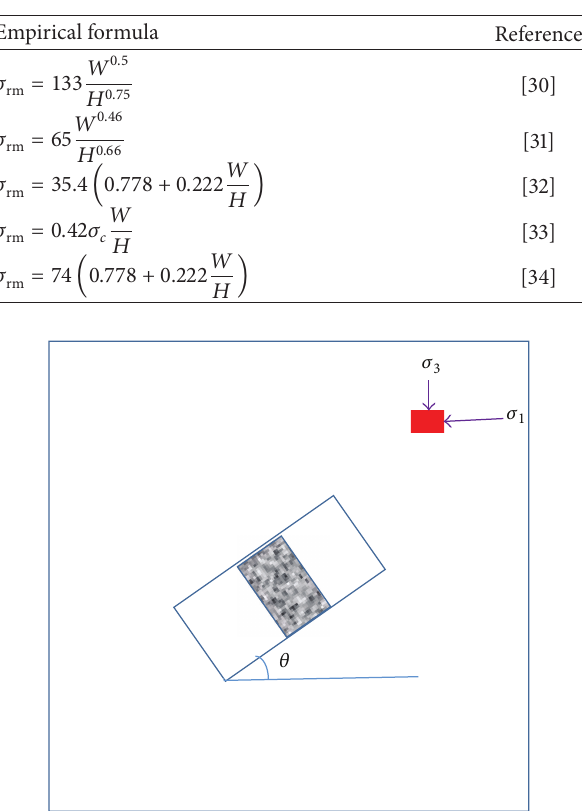
Figure 25: Direction of 𝜎 1 acting on the pillar at various angles.